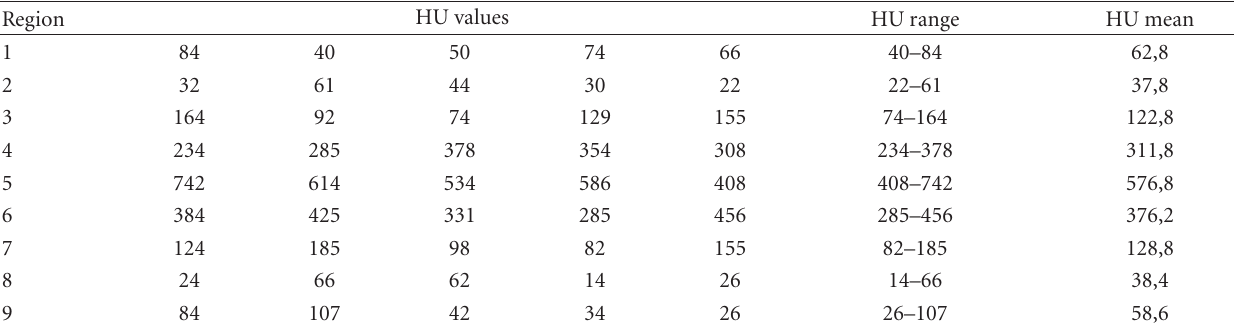
Region 1: right retromolar pad region of human cadaver bone. Region 2: right first molar region of human cadaver bone. Region 3: right first premolar molar region of human cadaver bone. Region 4: right lateral region of human cadaver bone. Region 5: midline (symphysis). Region 6: left lateral region of human cadaver bone. Region 7: left first premolar molar region of human cadaver bone. Region 8: left first molar region of human cadaver bone. Region 9: left retromolar pad region of human cadaver